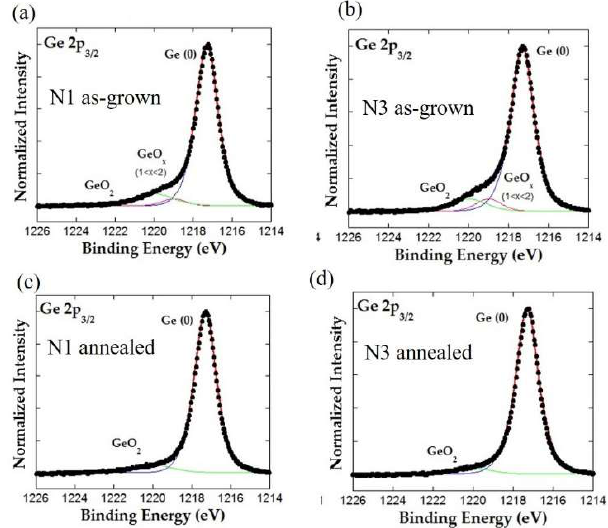
Figure 4. XPS measurements for the ( a , b ) as-grown and ( c , d ) annealed samples N1 and N3. The Ge oxidation states are indicated in the figure.